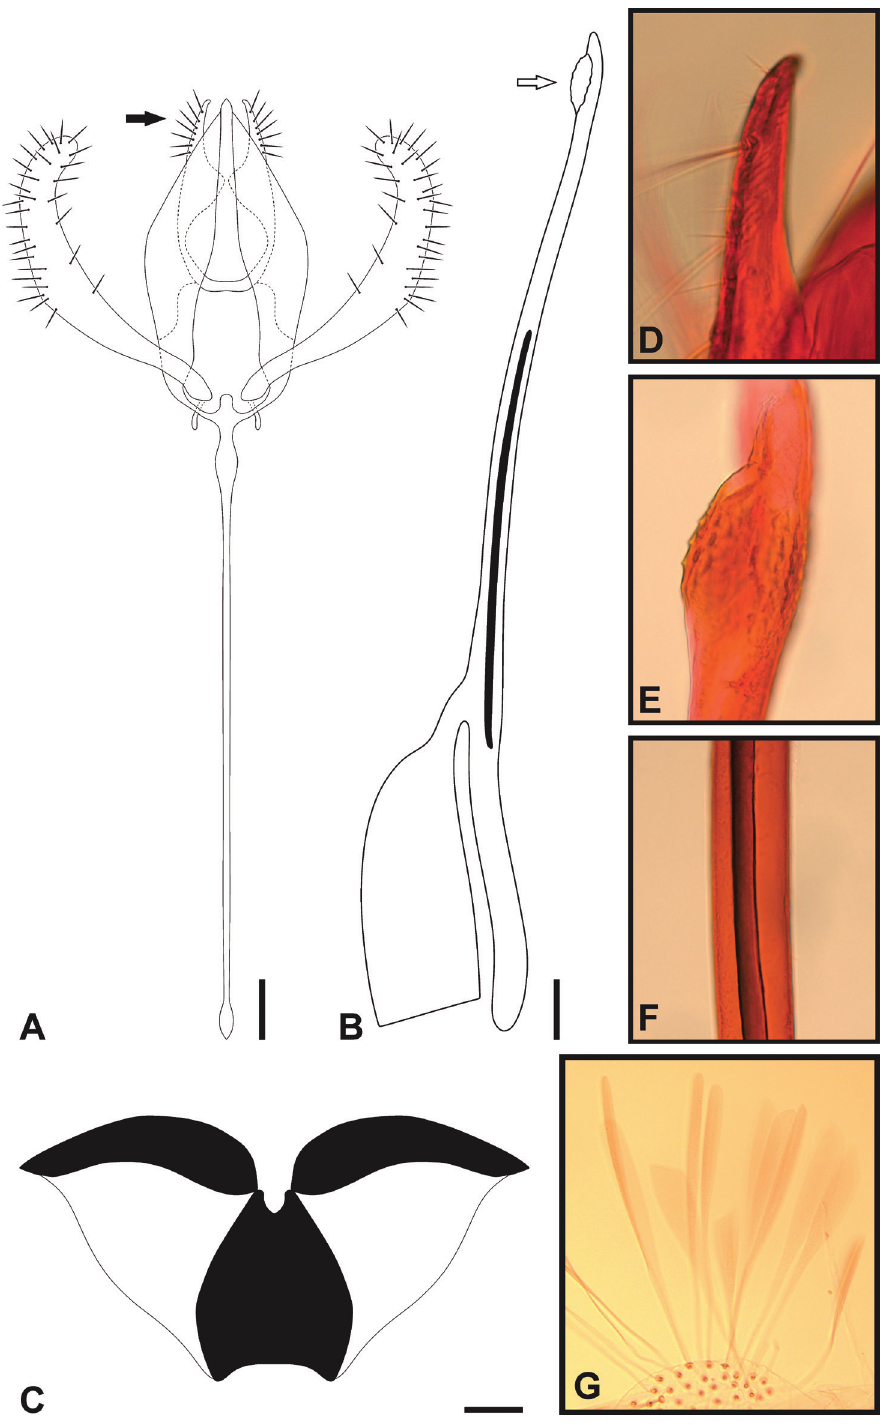
Fig. 5. Male genitalia and eighth segment of Helioandesia tarregai gen. et sp. nov., ♂, paratype (IDEA- LEPI-2020-021). A . Male genitalia, ventral view, phallus removed. B . Phallus, lateral view. C . Tergum and pleural lobes of eighth segment. D . Socius, closed arrow in A. E . Small spine-like cornuti on the vesica, open arrow in A. F . Medial part of the cornutus. G . Coremata between pleural lobes of segment VIII and genitalia. Scale bars: 0.1